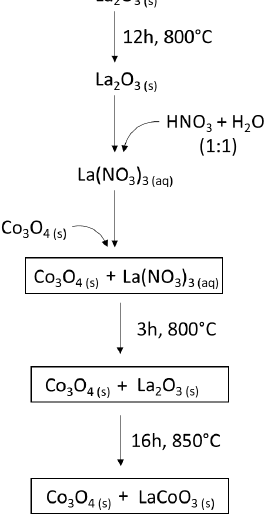
Figure 1. Scheme showing the synthesis of Co3.5La.